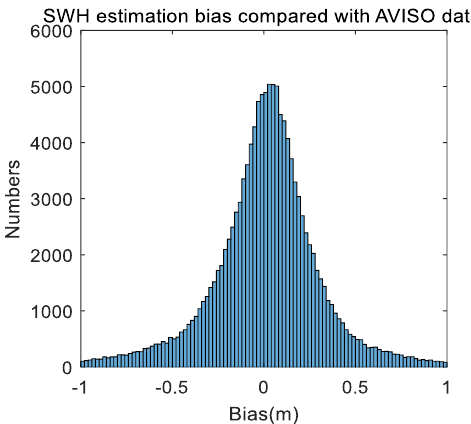
Figure 11. The difference distribution between the CYGNSS SWH estimate and AVISO satellite altimeter SWH observation. Table 2. Accuracy analysis of CYGNSS SWH estimates versus AVISO SWH (m).